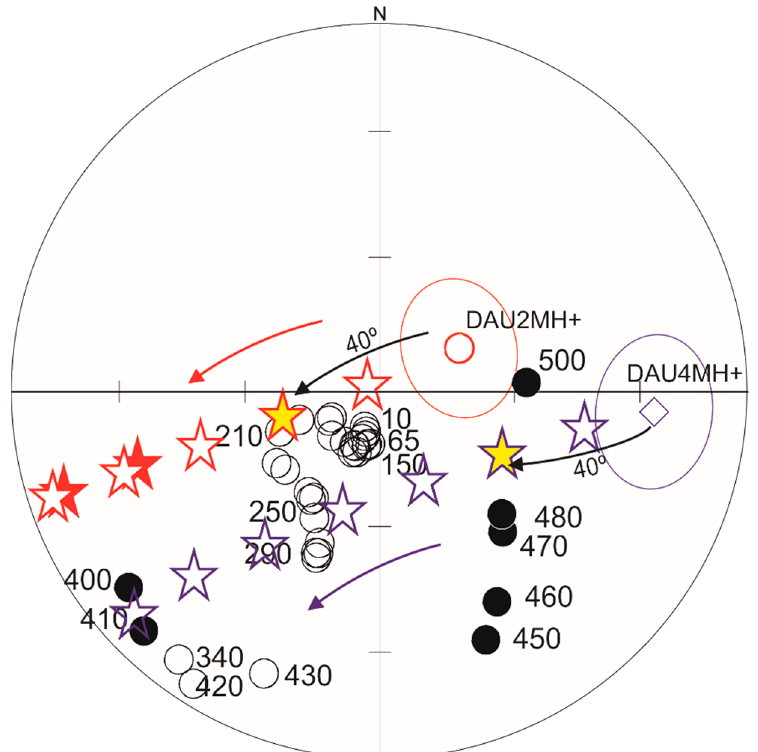
Figure 14. Equal area projections of DAU2MH+ and DAU4MH+ palaeomagnetic components with their ovals of the confidence limit α 95 against reference path of palaeomagnetic directions expected for area of SW Oscar II Land if it constituted part of Baltica in the Phanerozoic; stars represents gradual rotation of palaeomagnetic components around horizontal axis N 160°, oriented parallel to the West Spitsbergen Fold and Thrust Belt–Knipovich Ridge trend; red and blue arrows pointing to direction of rotation according to listric faulting; stars filled in yellow marked rotation by an angle of 40°.